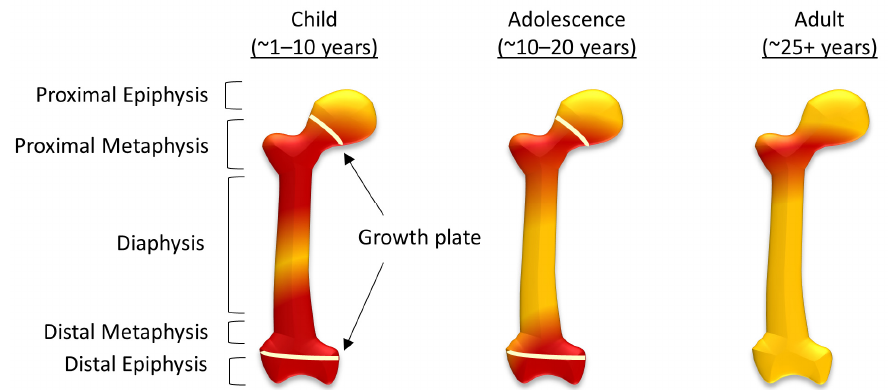
Figure 1. The conversion of red to yellow bone marrow in the femur. The distribution of red and yellow bone marrow in children, adolescents and in adulthood, showing structural components of the femur including the diaphysis, metaphysis, and epiphysis (both sulphur proximal and distal) and the growth plates during childhood and adolescence.